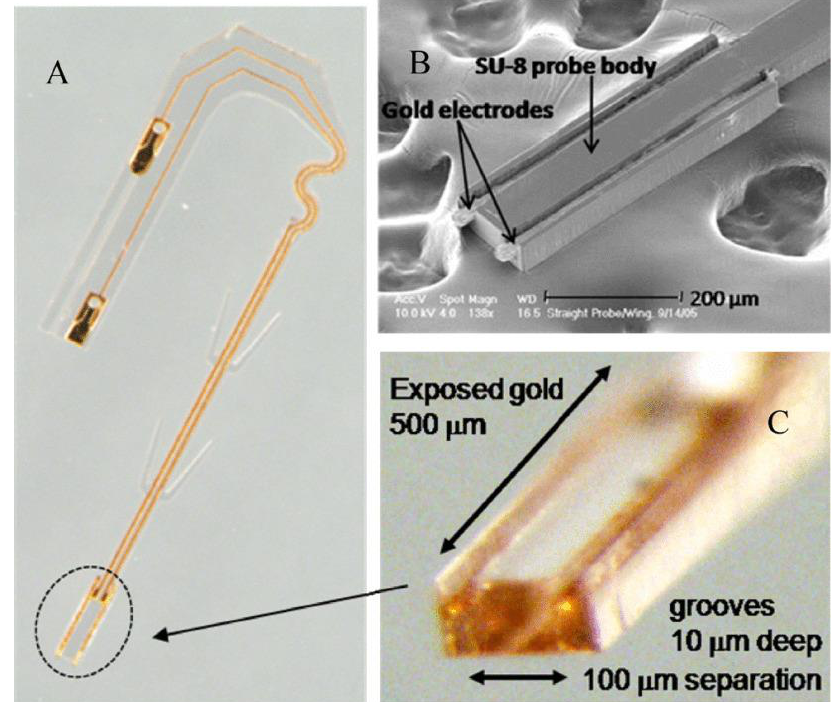
Figure 12. ( A ) Optical image of the “J-shaped” SU-8 microprobe featuring bipolar gold electrodes recessed in “grooves” designed to guide fiber growth, “wings” to maintain central position within implant channels, serpentine feature for greater flexion, and wire bonding pads. ( B ) SEM image of bipolar gold electrodes in recessed grooves. ( C ) Close-up image of bipolar groove electrode tip. © 2008 IEEE. Reprinted from Cho et al. [29] with permission.